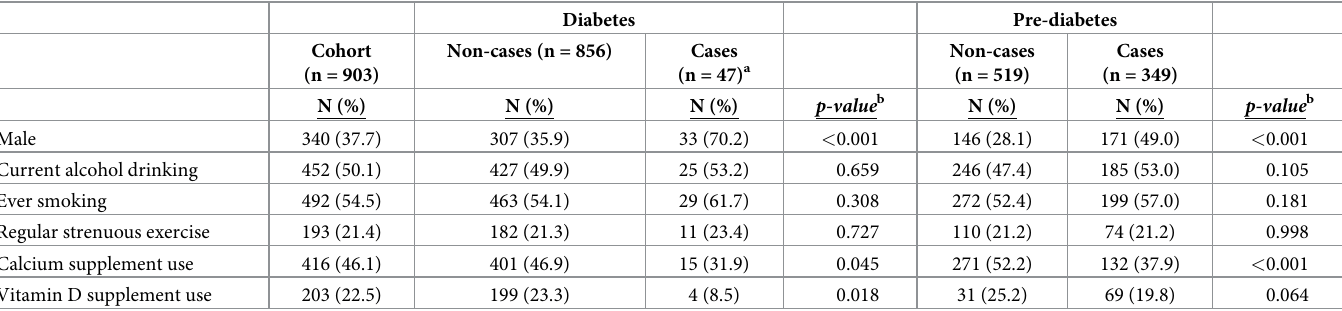
Table 2. Baseline characteristics of non-cases, type 2 diabetes mellitus cases and pre-diabetes cases in the Rancho Bernardo cohort, discrete variables, 1997–1999.